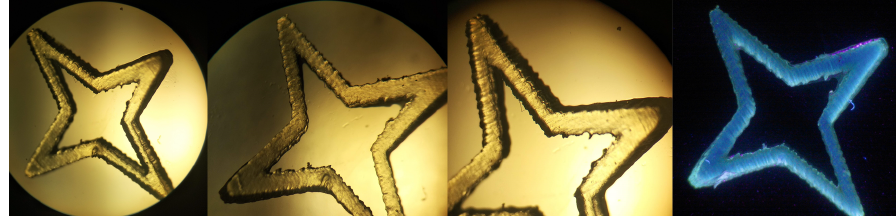
Figure 14. The pattern obtained after the 3D printing experiment based on formulation with T1 (0.07% wt.)/EDB (0.5% wt.)/IOD (0.33% wt.) and TMPTA. Catalysts 2020 , 10 , x FOR PEER REVIEW